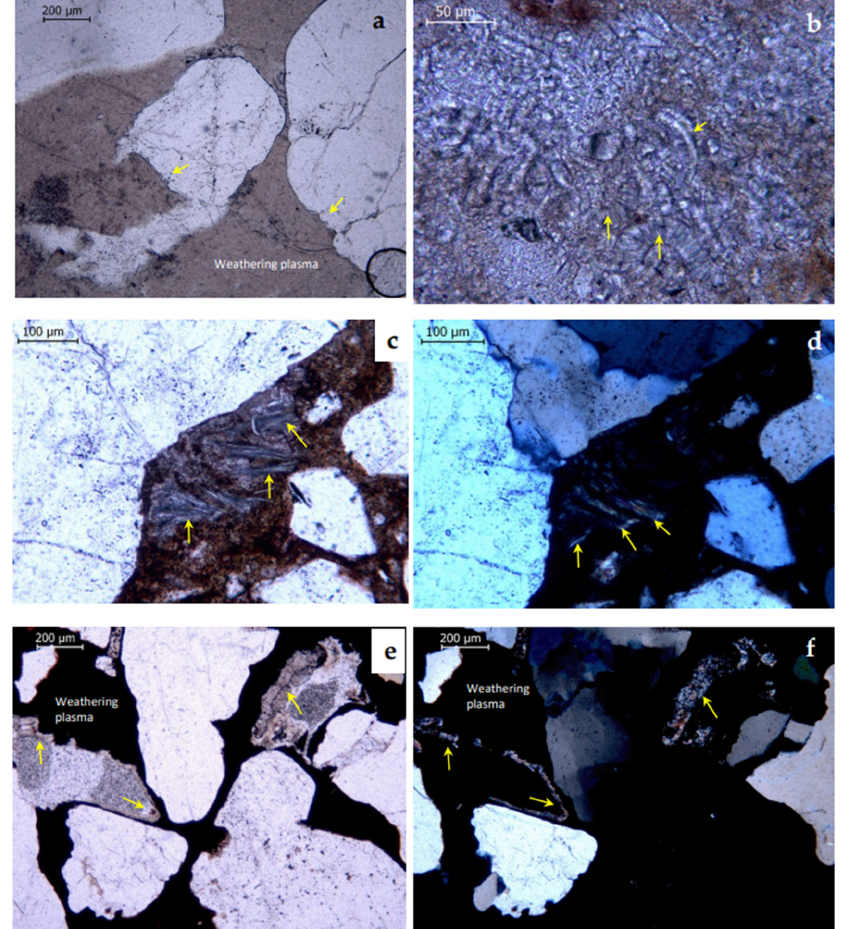
Figure 2. ( a ) Natural Light (NL) microphotograph. Skeleton of polycrystalline quartz grains (yellow arrows) with corrosion gulfs set in a weathering plasma of CT opal and 1:1 phyllosilicate (birefrin- gent, silcretes); ( b ) Microphotograph (NL). Small accordion-shaped kaolinites (1:1 phyllosilicates of neoformation(yellow arrows); ( c ) Microphotograph (NL) and ( d ) microphotograph (crossed nicols, CN) of muscovites flakes with loss of interference colour (yellow arrows); ( e ) Microphotograph (NL) and ( f ) microphotograph (CN) of isotropic mass called weathering plasma formed by CT opal and iron oxyhydroxides (which gives a purple hue to the Zamora building stone), in addition, the partial filling of the porous system (cutan, to designate a modification of the texture, structure or fabric at natual surfaces in soil materials, due to concentration of particular soil constituents or in situ modification of the plasma) by fibrous silica or CT opal (yellow arrows), which have originated by traces of roots (bioturbation) in the tropical palaeosoil (pedogenic